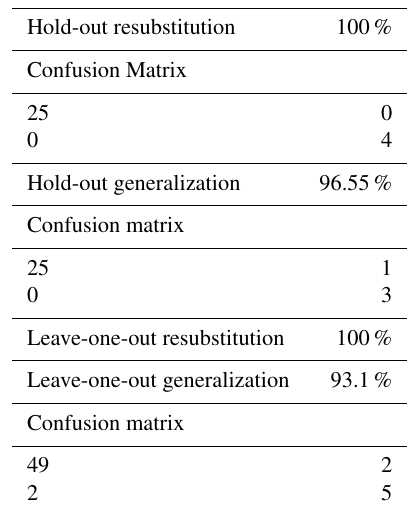
Figure 9. Scatterplot of the tlength feature for the SGP30 eCO 2 and TVOC outputs and the four classes of VILE. Table 3. Classification results of the tlength feature from the SGP30 eCO 2 and TVOC outputs and the 8 July to 19 September campaign data with kNN ( k = 1) and the ATND two-class